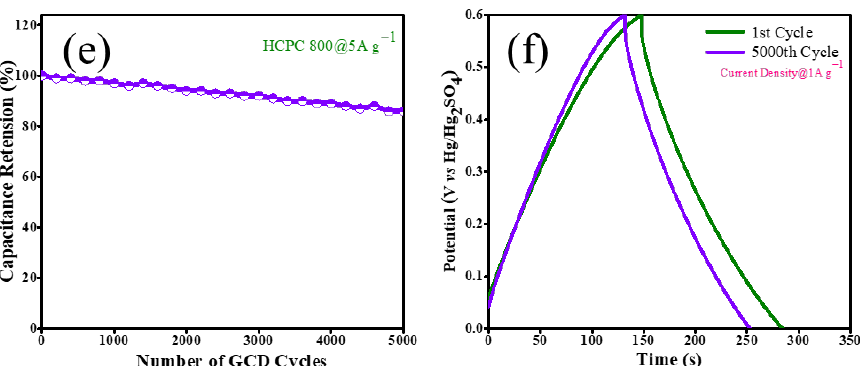
Figure 7. CV ( a ), GCD ( b ), Specific capacitance calculated from GCD ( c ), Nyquist plots ( d ) of HCPC- 700, HCPC-800 and HCPC-900, Cycling stability of HCPC-800 at 5A/g ( e ) and GCD for 1st and 5000th of HCPC-800 ( f ).